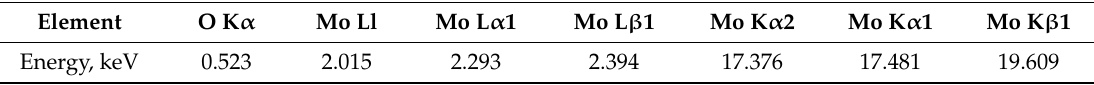
Table 4. Characteristic energy lines for oxygen and